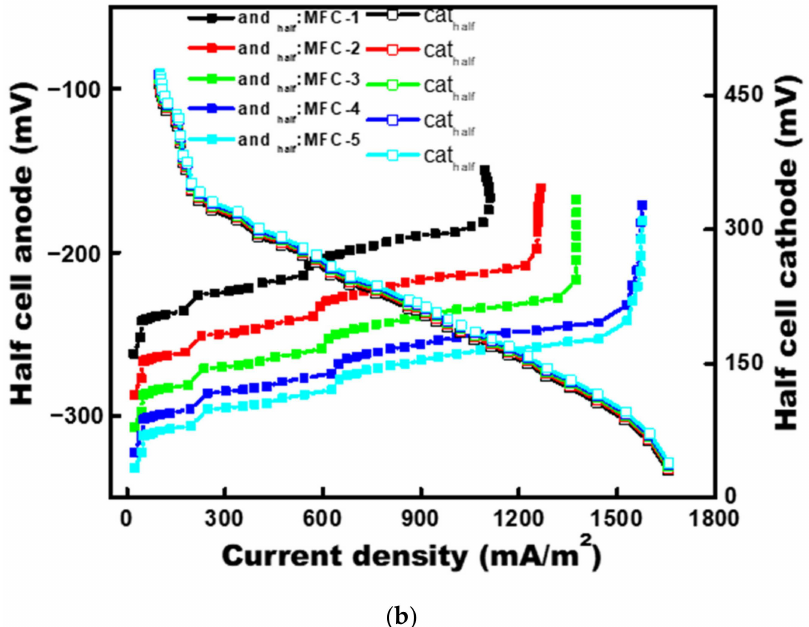
Figure 7. ( a ) Polarization study of unaltered and Fe 3 O 4 @PSA-C altered anode; the power density and voltage data points are presented as solid and open symbols, respectively. ( b ) Anode and cathode half-cell analysis to understand the variation in anode after modification with Fe 3 O 4 @PSA-C. Open and solid symbols represent cathode and anode half-cell voltages,